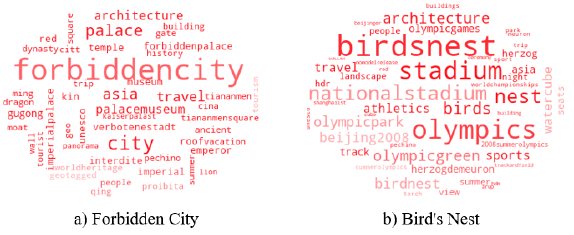
Figure 3. Word cloud examples generated by user-annotated Flickr photo tags.